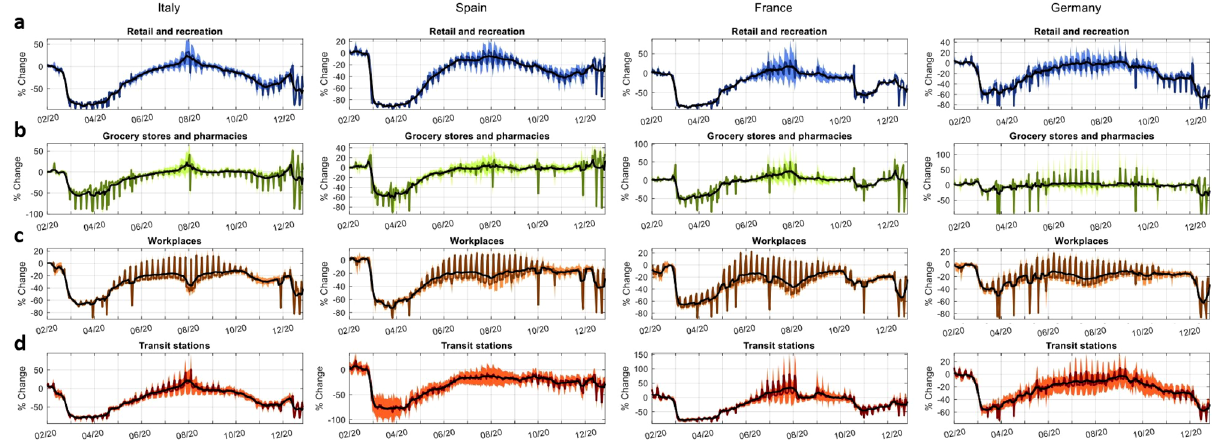
Figure 5. Line diagrams of the Google mobility trends dynamics. The line diagrams show the average dynamic of phone-tracking-based changes in mobility patterns of individuals to retail and recreation ( a ), grocery stores and pharmacies ( b ), workplaces ( c ) and transit stations ( d ) across administrative regions in Italy, Spain, France and Germany. Colored solid lines represent the real average time series dynamics, black solid lines show the 7-day moving averages, shaded areas indicate the 1-standard deviation bands. Administrative regions are at NUTS2 level (regional) for all the countries under